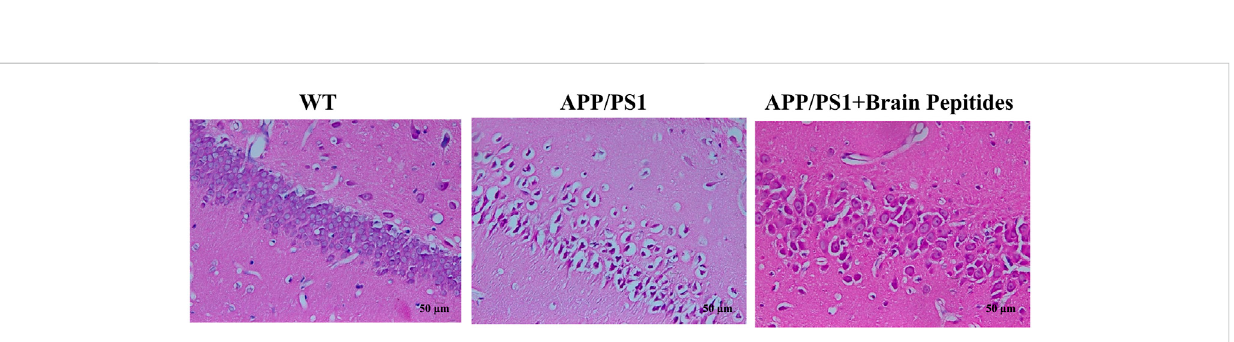
Cerebroprotein hydrolysate improves the morphology and number of hippocampal neurons in APP/PS1 mice (haematoxylin-eosin staining, × 200) (n =